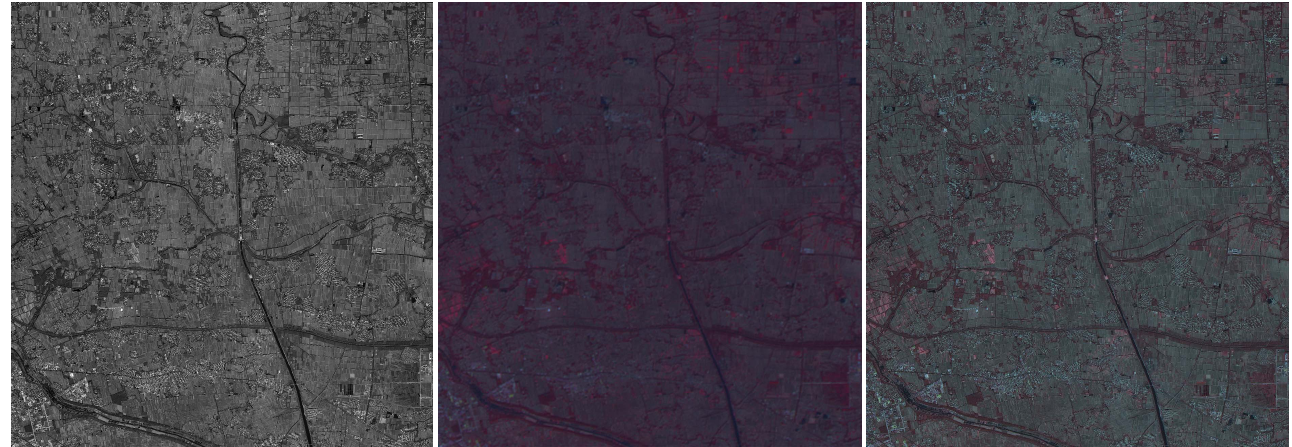
Figure 2. The panchromatic image of Beijing-1 small satellite(P1)